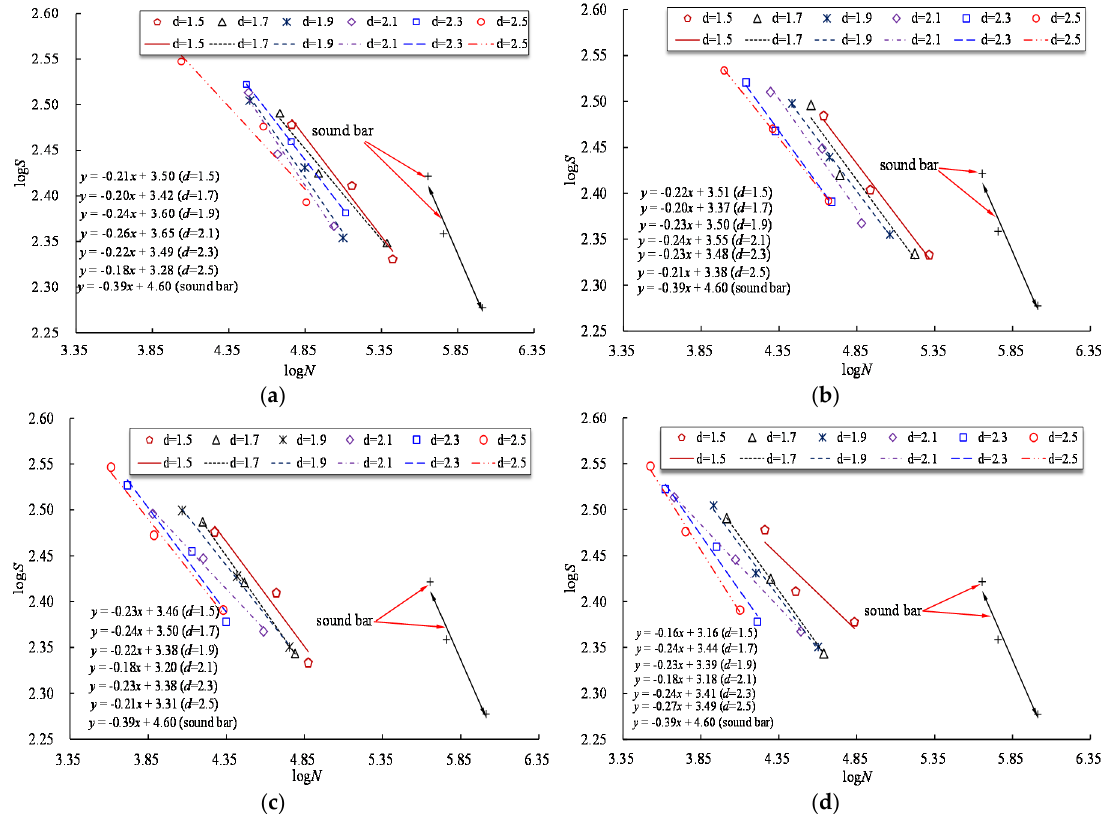
Figure 11. Log S versus log N curves for specimens with different notch shapes. ( a ) Axial ellipse; ( b ) radial ellipse; ( c ) length-variable triangle; ( d ) triangle.